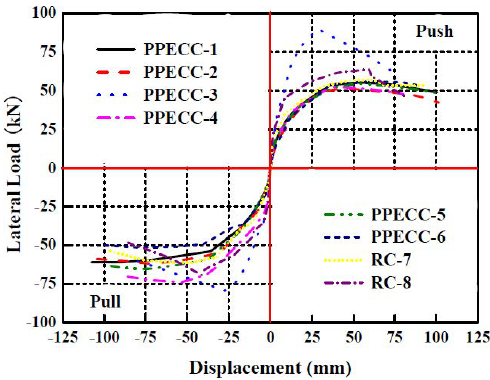
Fig. 5 Skeleton curves of six